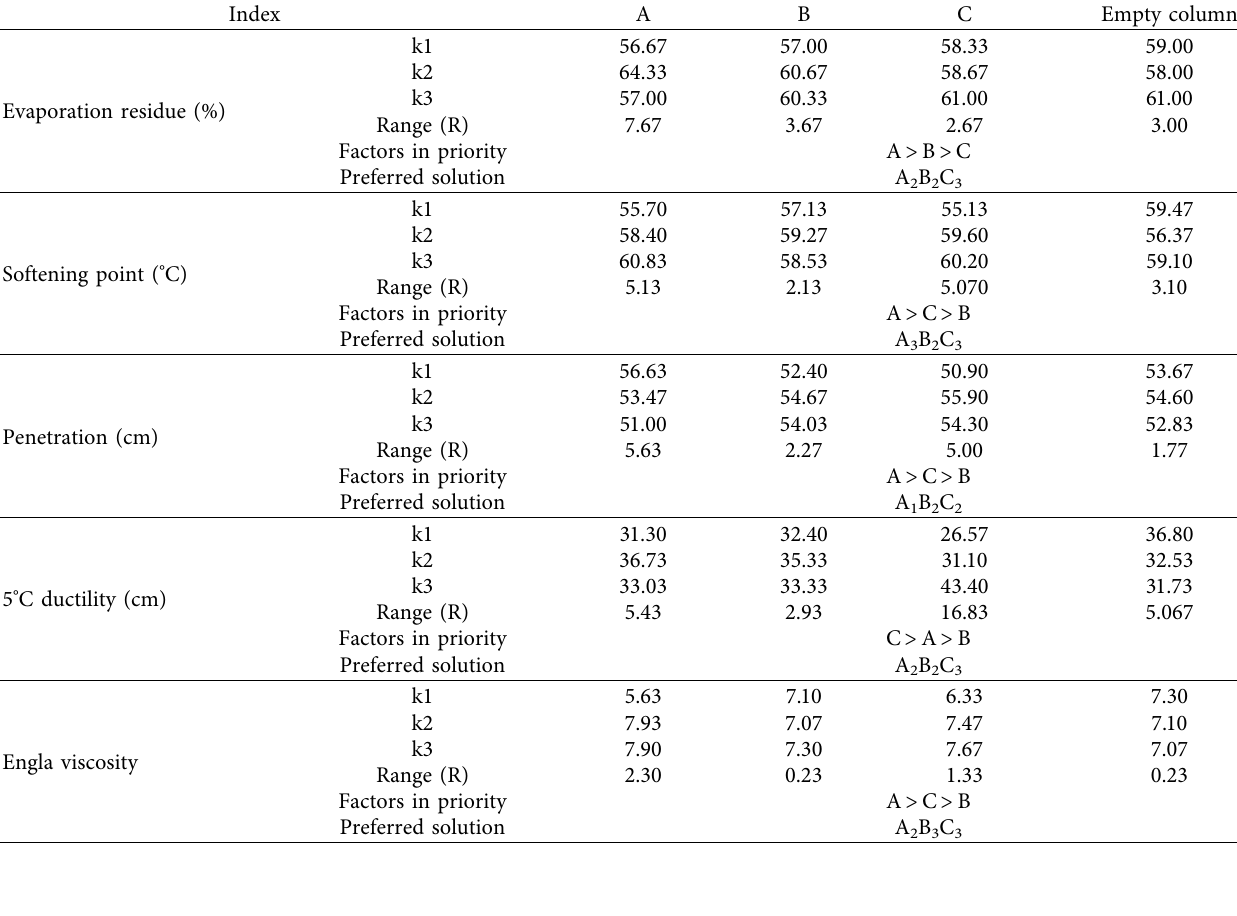
Table 9: Analysis of the range results of the orthogonal